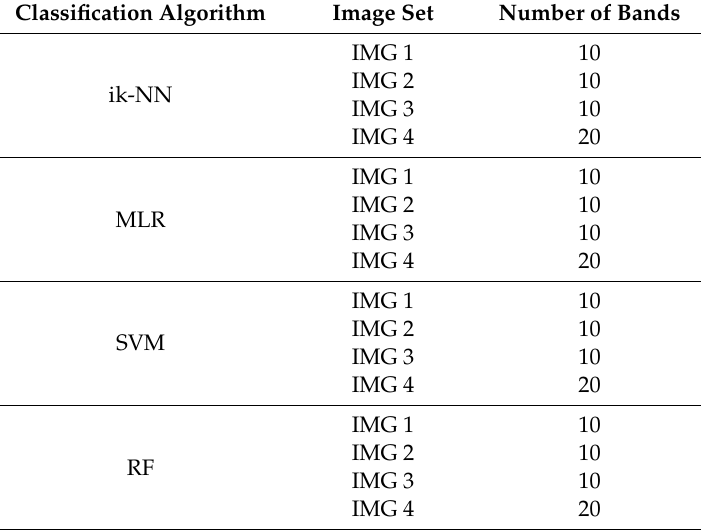
Table 4. Classifiers and seasonal bands. Ik-NN, improved k-nearest neighbors; MLR, multinomial logistic regression; SVM, support vector machine; RF, random